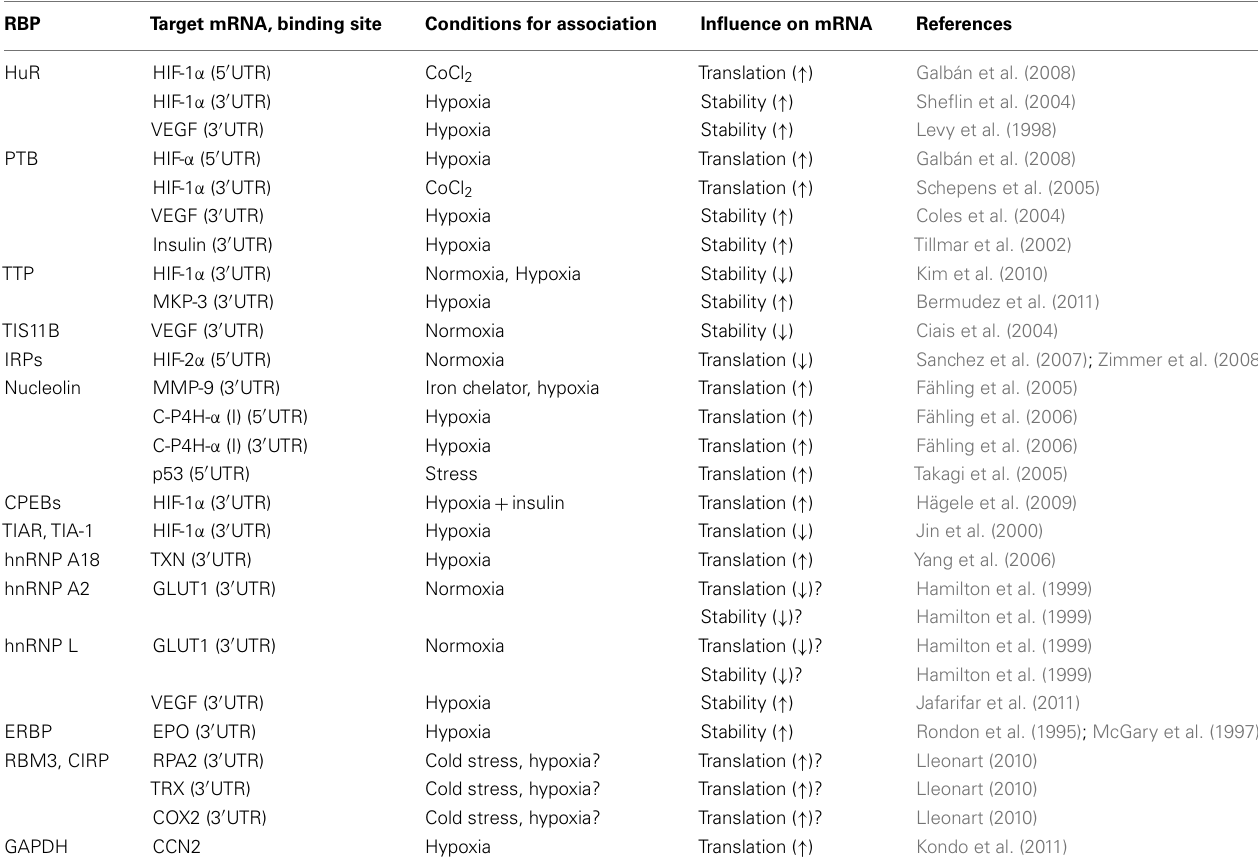
Table 1 | RNA-binding proteins implicated in the hypoxic response.